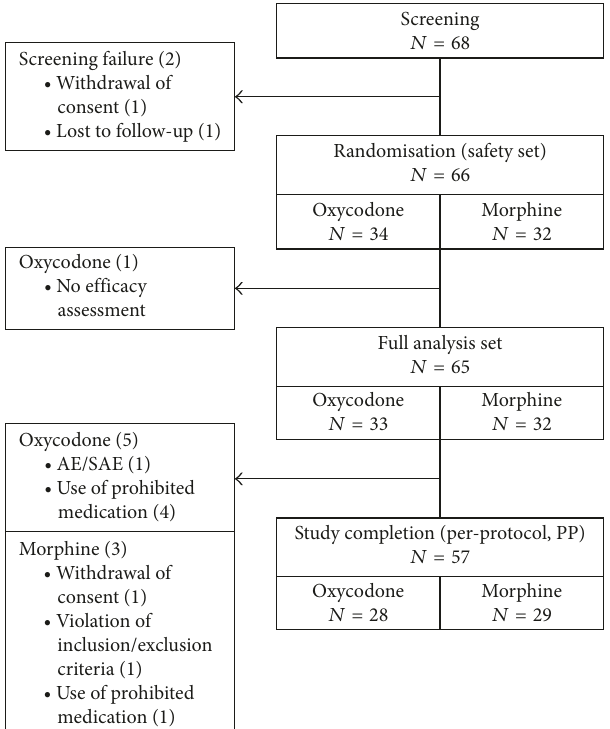
Figure 2: Flow of patients through the